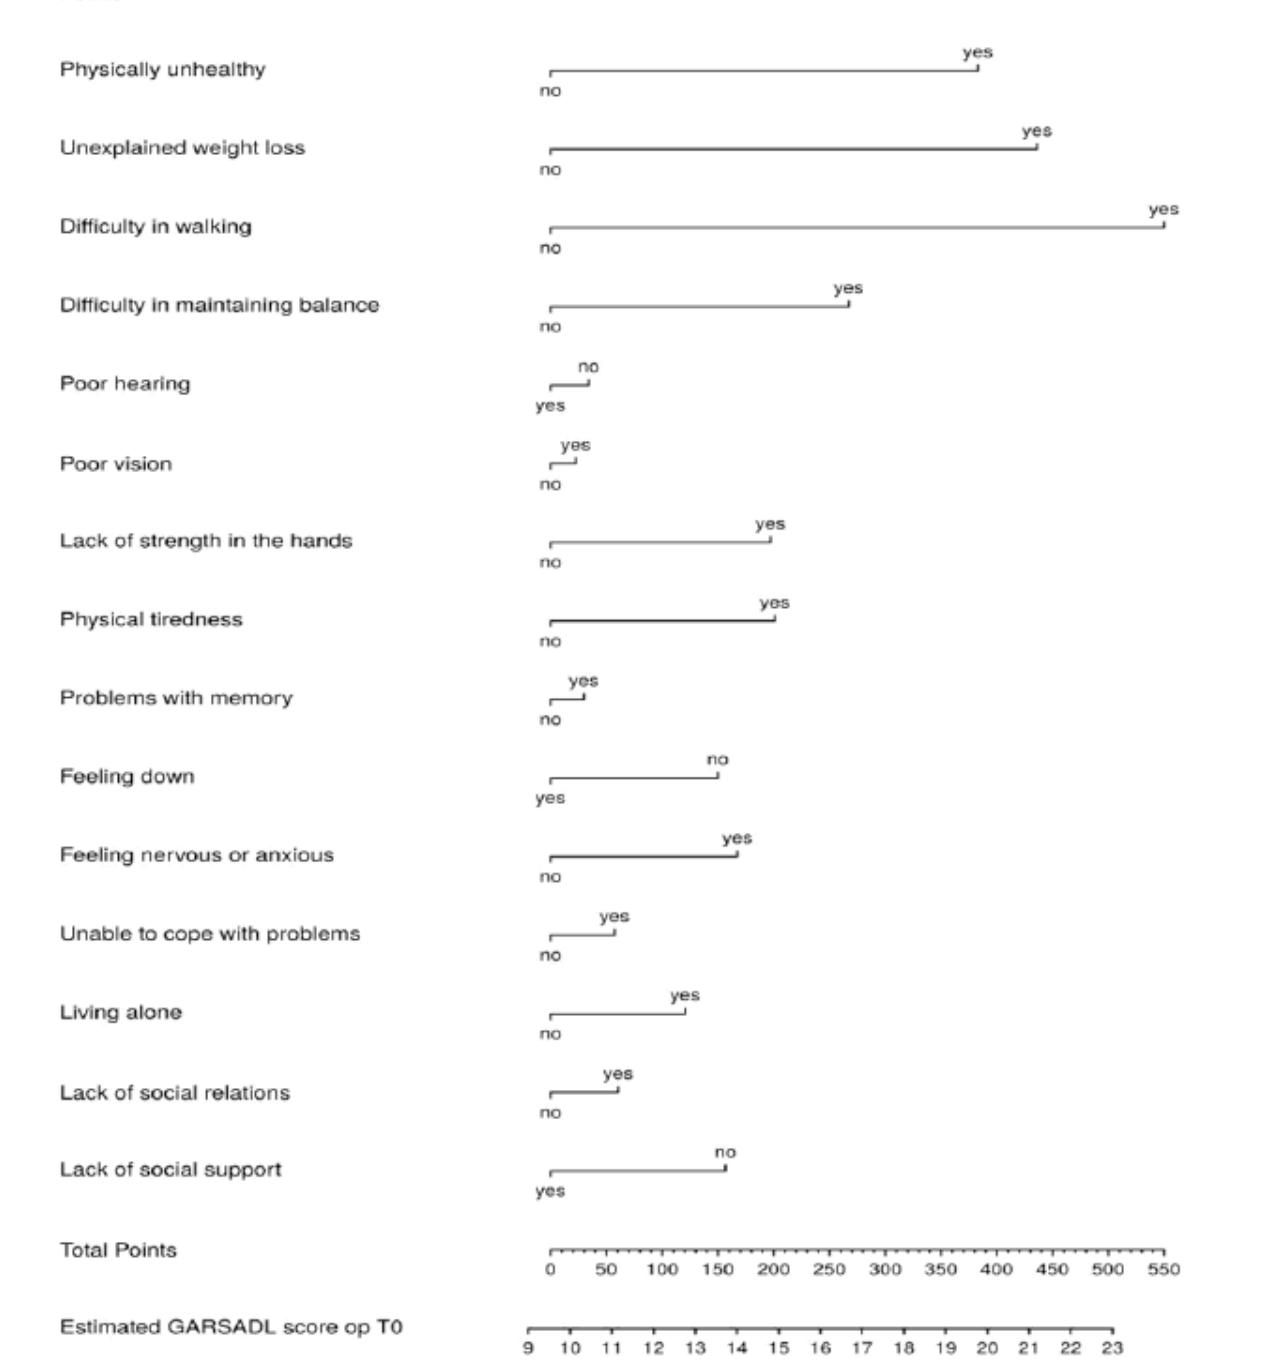
Figure A4. Nomogram ADL disability score at Figure 4. Nomogram ADL disability score at T0.